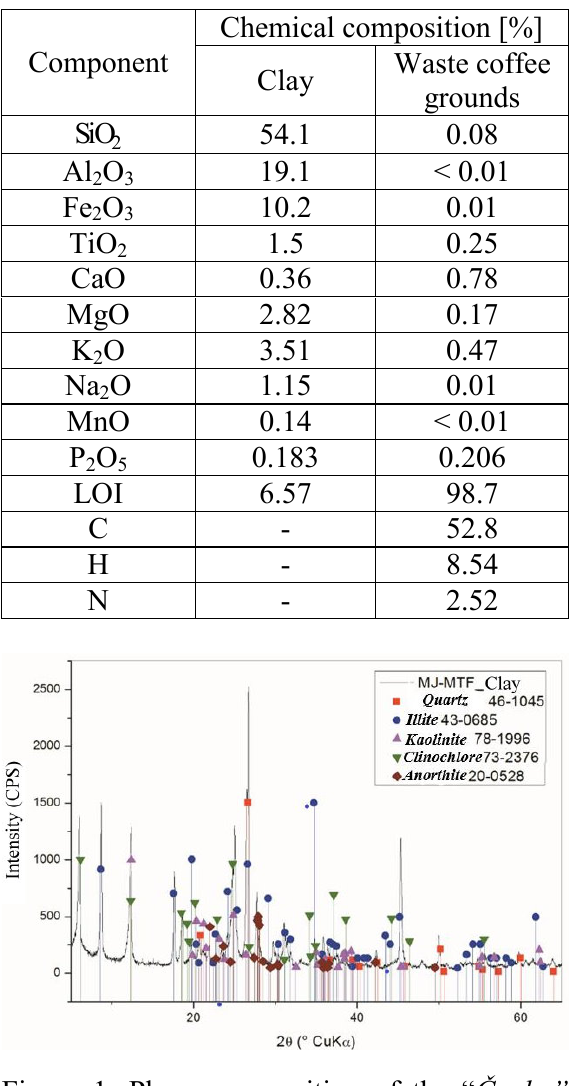
Figure 2. DTA/TG/DTG of the “ Čavka ”